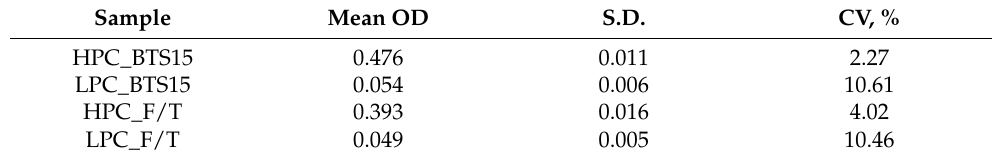
Table 11. CV values calculated for bench-top (BTS) and freeze-thaw (F/T) sample stability assessment.